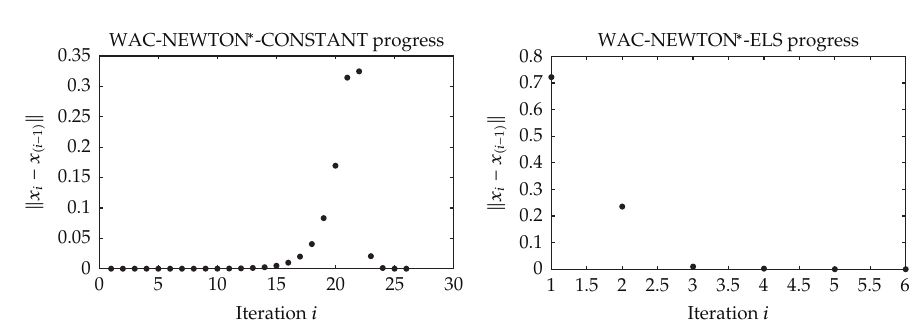
Figure 5: The “wasted iteration”